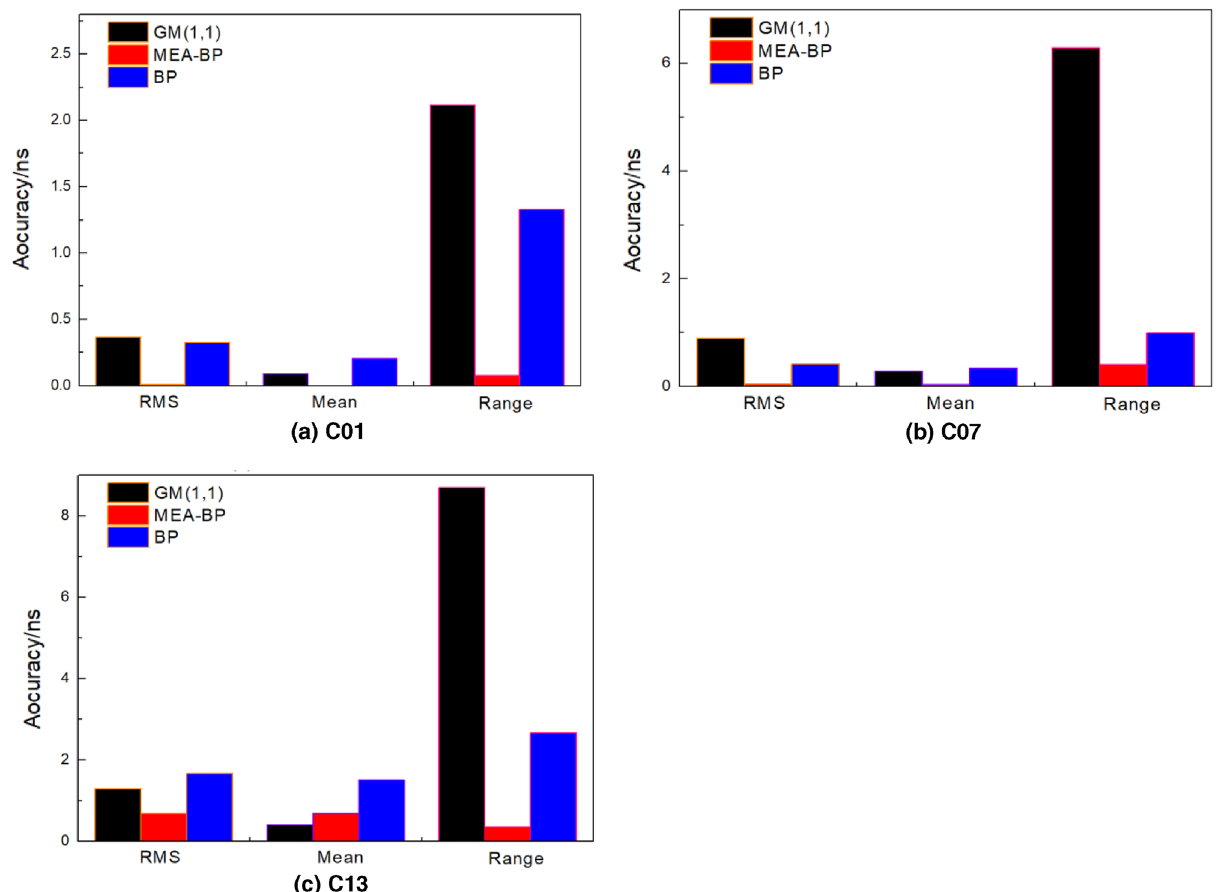
Figure 7. Prediction bar chart of 12 h clock bias of the three satellites.